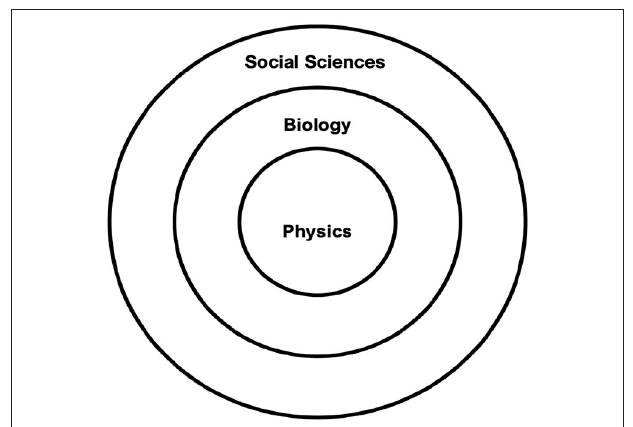
FIGURE 1 | Earth metaphor for the three-tier framework for modeling human action. The familiar direction is from the crust inwards and we explore the outward direction (Art by Anoush